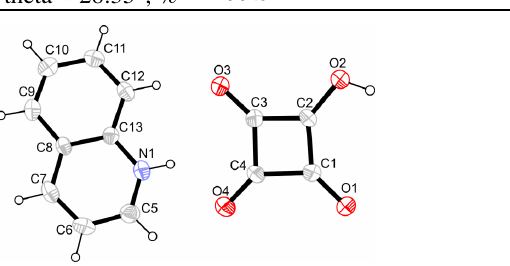
Figure 1. The structure of quinolinium hydrogensquarate, HqnHsq, with displacement ellipsoids drawn at the 30% probability